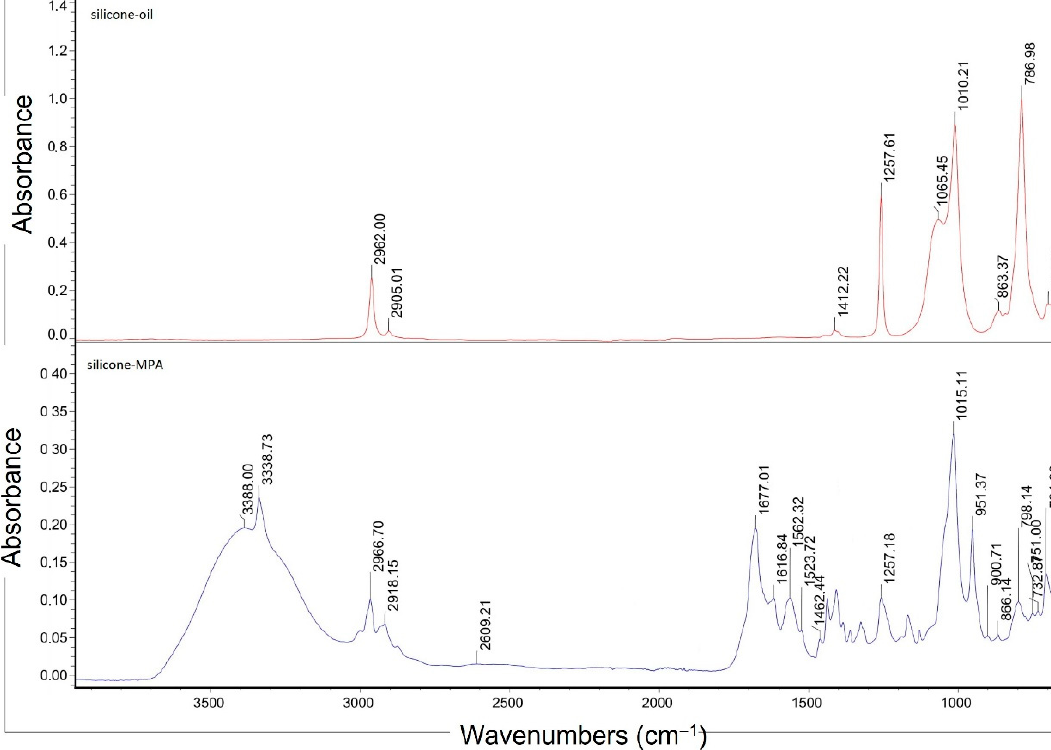
Figure 3. FTIR spectra of unmodified silicone oil (red) and thiolated derivative—silicone-MPA (blue).